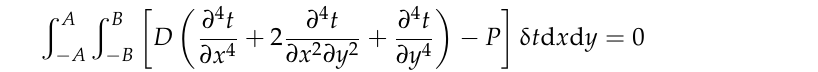
Figure 2. ( a ) The first vibration mode of the resonator; ( b ) The second vibration mode of the resonator.